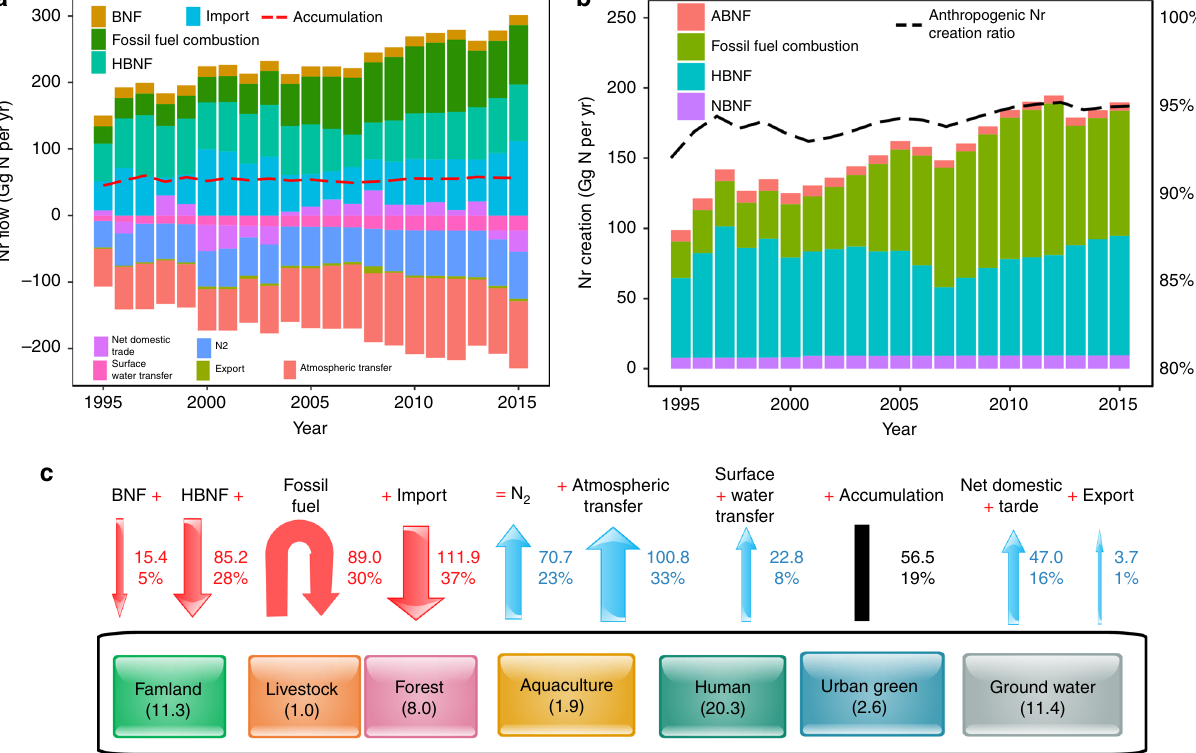
Fig. 2 Temporal variation of N balance in Guangzhou (Units are in Gg N y − 1 ). a The Nr input, output, and accumulation. b The Nr creation. c Schematic of N balance in 2015. ABNF, agricultural biological N fi xation; HBNF, Haber- Bosch N fi xation; NBNF, natural biological N fi xation; Atmospheric transfer: Nr transfer to the surrounding areas; Surface water transfer: Nr transfer to oceans.